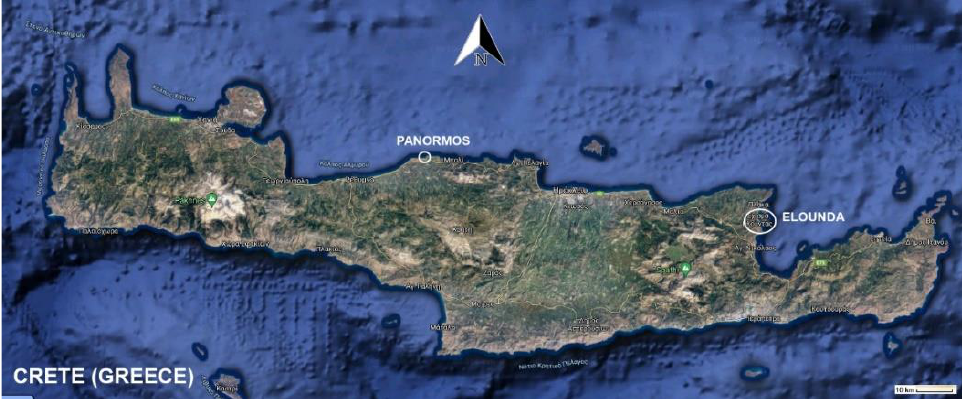
Figure 12. Map of Crete (Greece) indicating the location of the case studies discussed in the text.